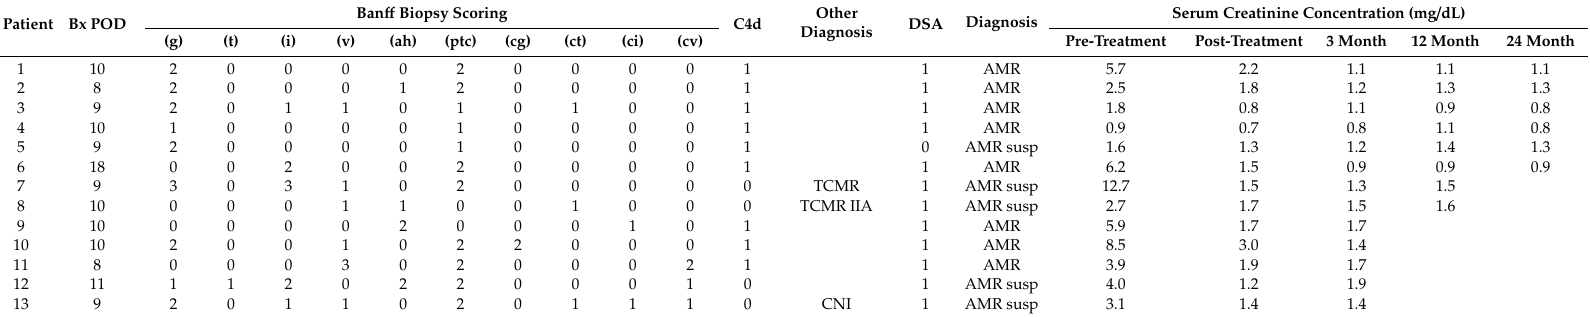
Table 2. Protocol biopsy findings and serum creatinine concentration before primary AMR treatment and during the follow-up period. Patient Bx